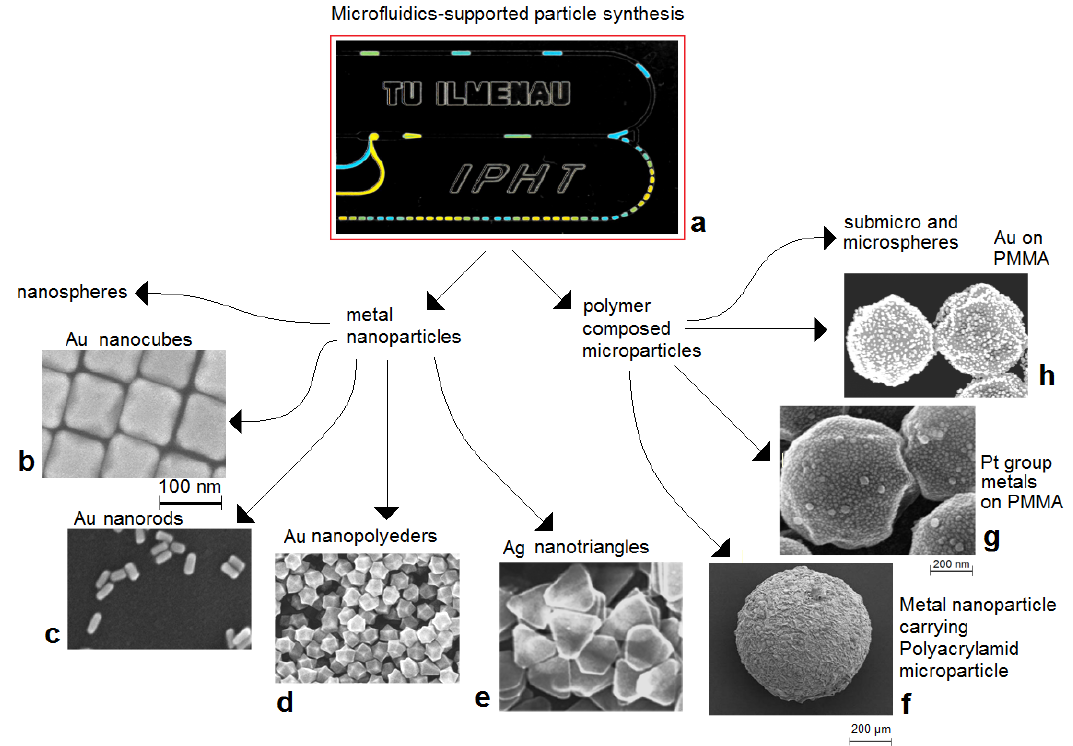
Figure 1. Examples of metal nano and polymer composite particles synthesized by use of microfluidic preparation steps: ( a ) example of a chip device for generation of microfluid segment sequences for systematic variation of reactant concentration ratios in micro flow syntheses [23], ( b ) gold nanocubes [20], ( c ) gold nanorods, ( d ) gold polyeders [20], ( e ) flat triangular silver nanoprisms [21], ( f ) polyacrylamid submillimeter composite particle [24], ( g ) submicrometer composite particle with two incorporated types of metal nanoparticles [25], ( f ) submicrometer composite particle with gold nanoparticles